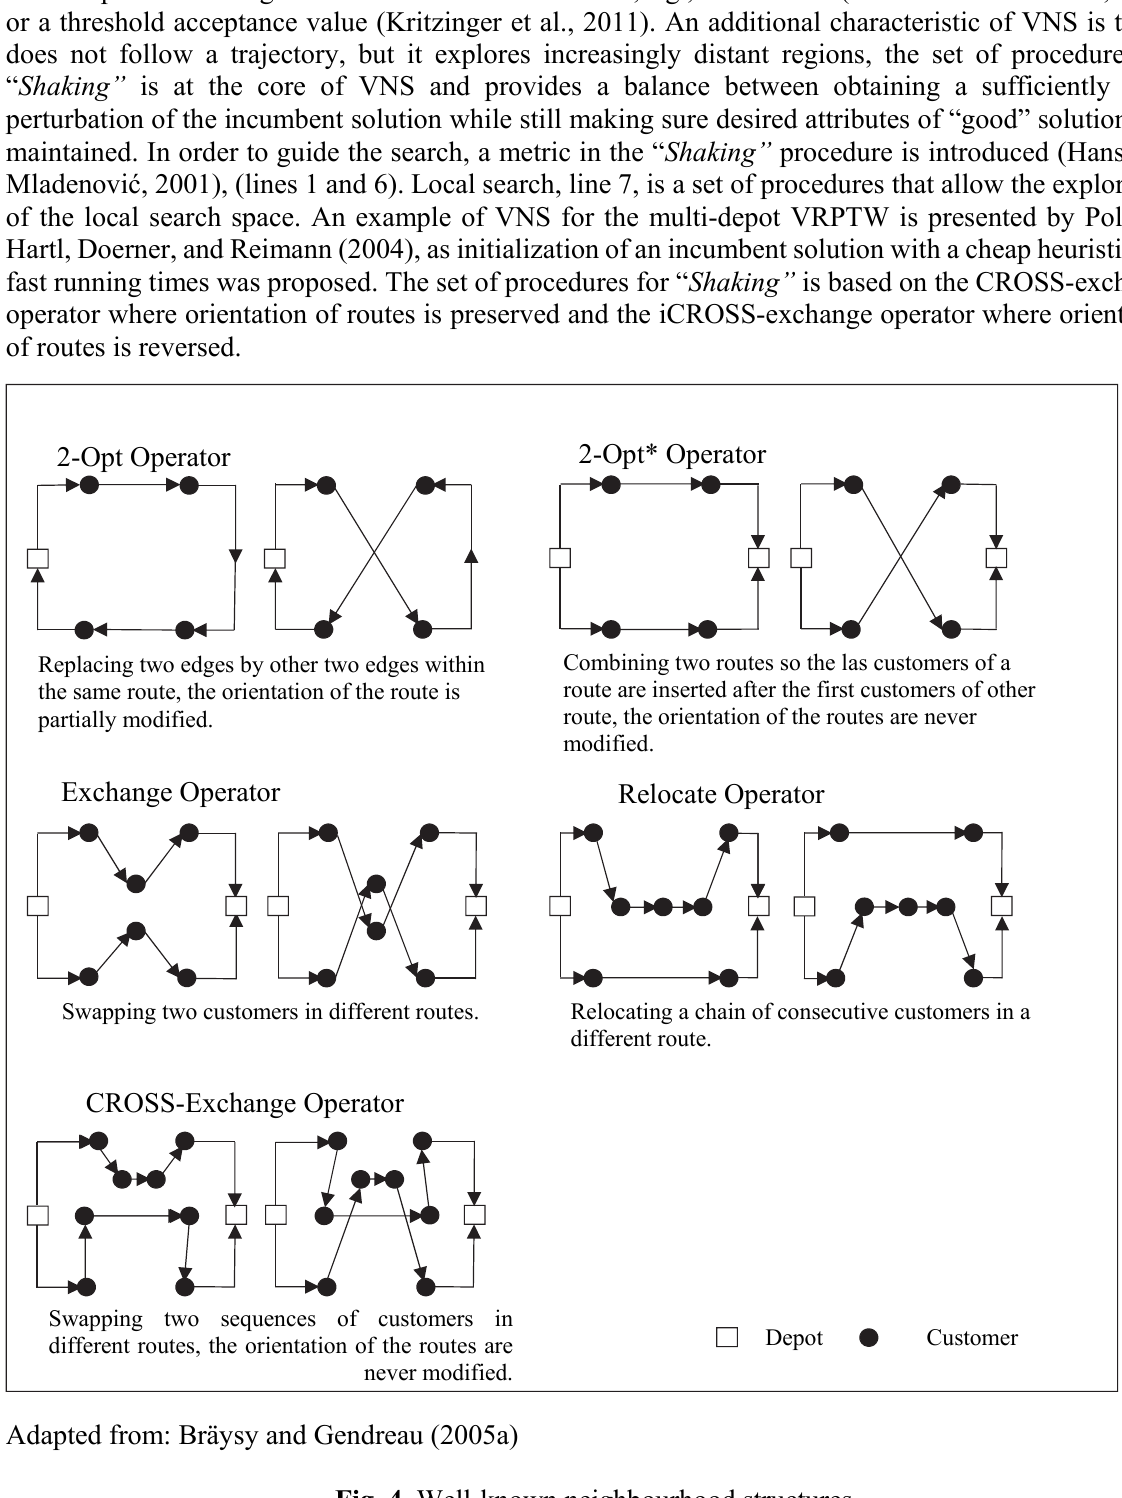
Fig. 4. Well-known neighbourhood